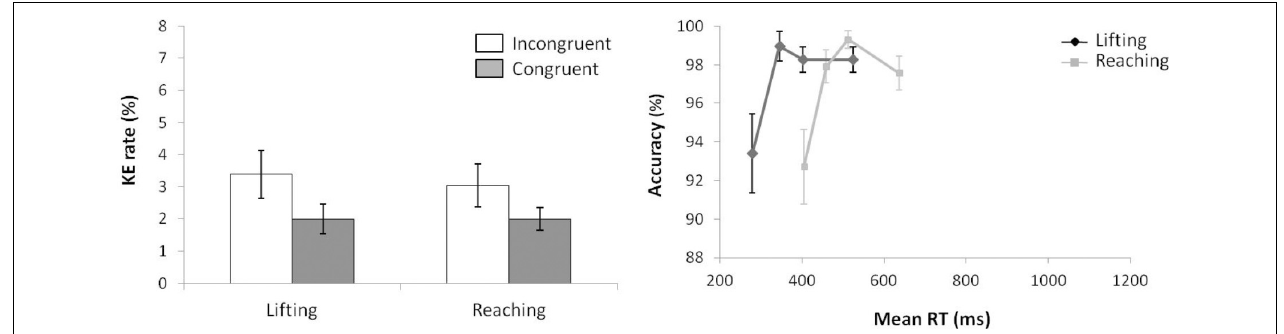
FIGURE 3 | (Left) Interactions of movement × congruence with respect to kinematic error rate. (Right) Delta-plots showing conditional accuracy functions for incongruent trials as a function of response speed (expressed in reaction time quartiles) for lifting action (gray square) and reaching action (black circle) in Experiment 1. Error bars represent the standard error of the